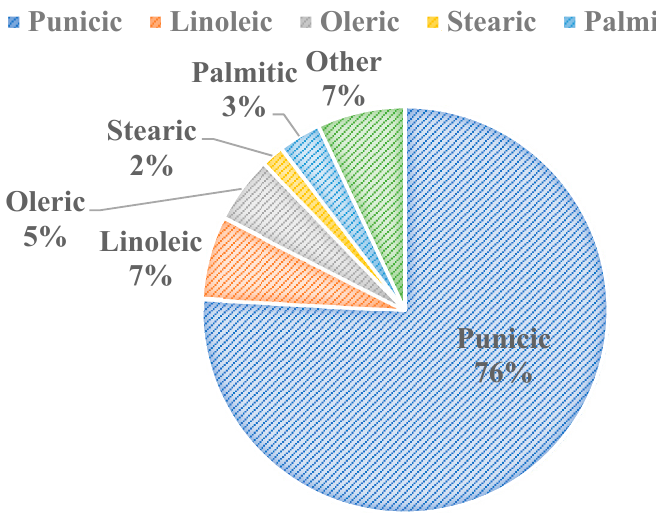
Figure 3. Major Fatty Acids in Pomegranate Seed Oil [11,20].